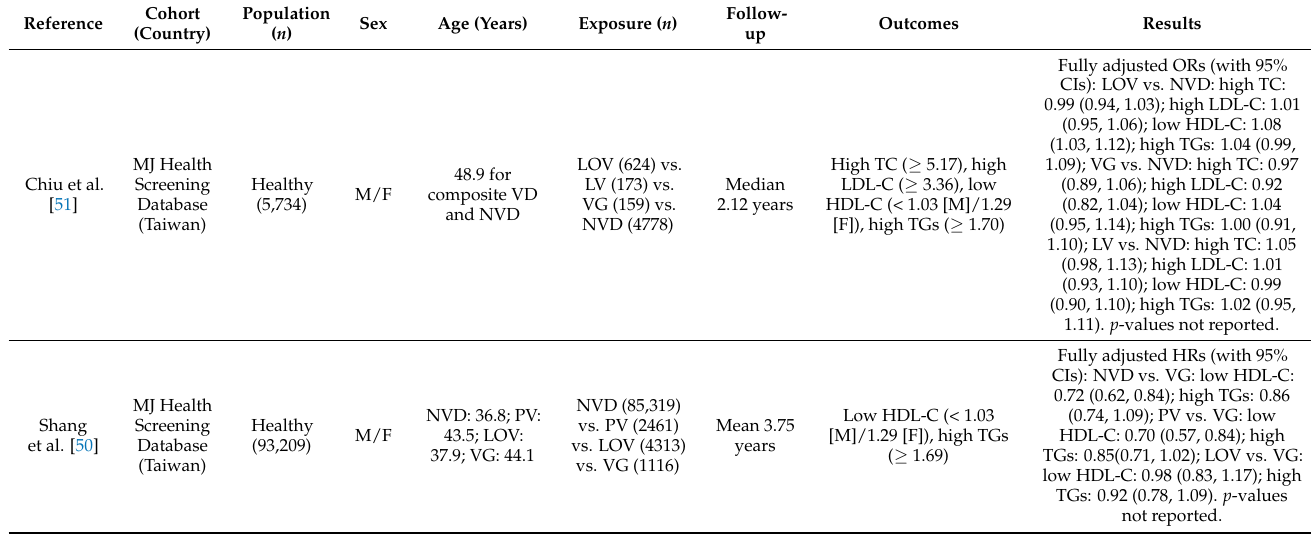
Table 4. Prospective Cohort Studies of Plant-Based Diets and Lipid